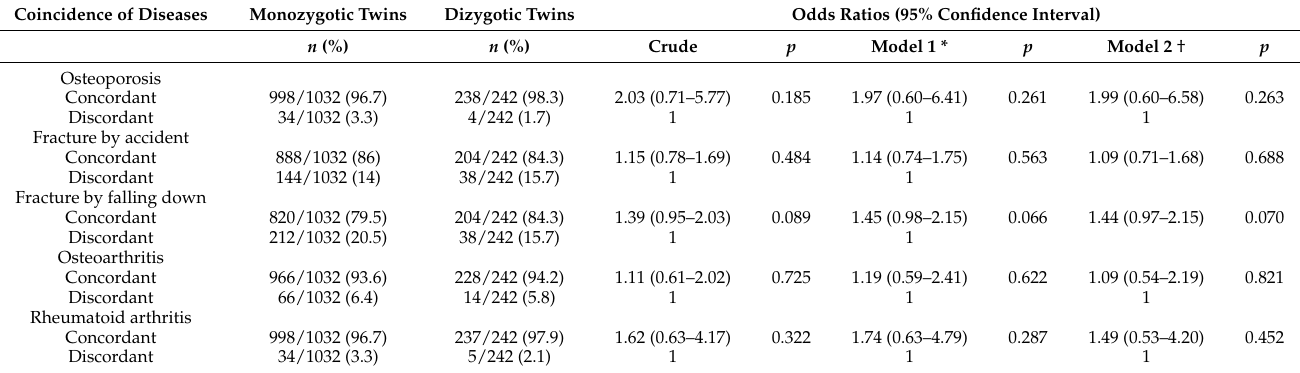
Table 2. Analysis of odds ratios with 95% confidence interval of coincidence of bone diseases in monozygotic twins compared to that in dizygotic twins (reference: positive/negative of diseases between